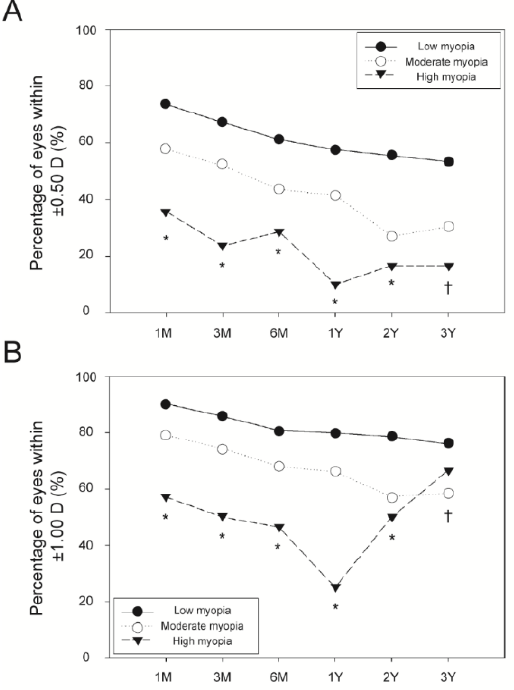
0.50 and 1.00 diopters ± ±